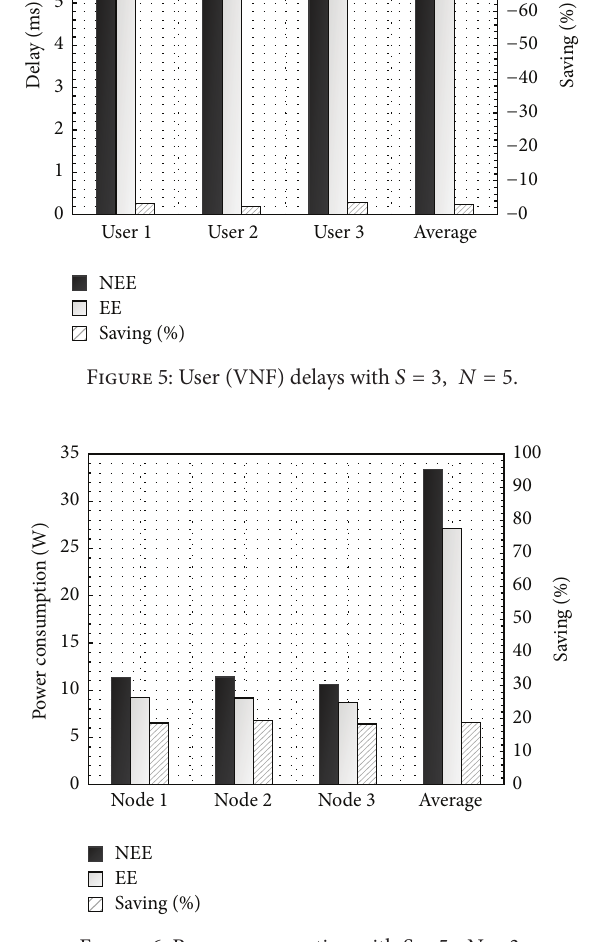
Figure 9: User (VNF) delays with 𝑆 = 5, 𝑁 =